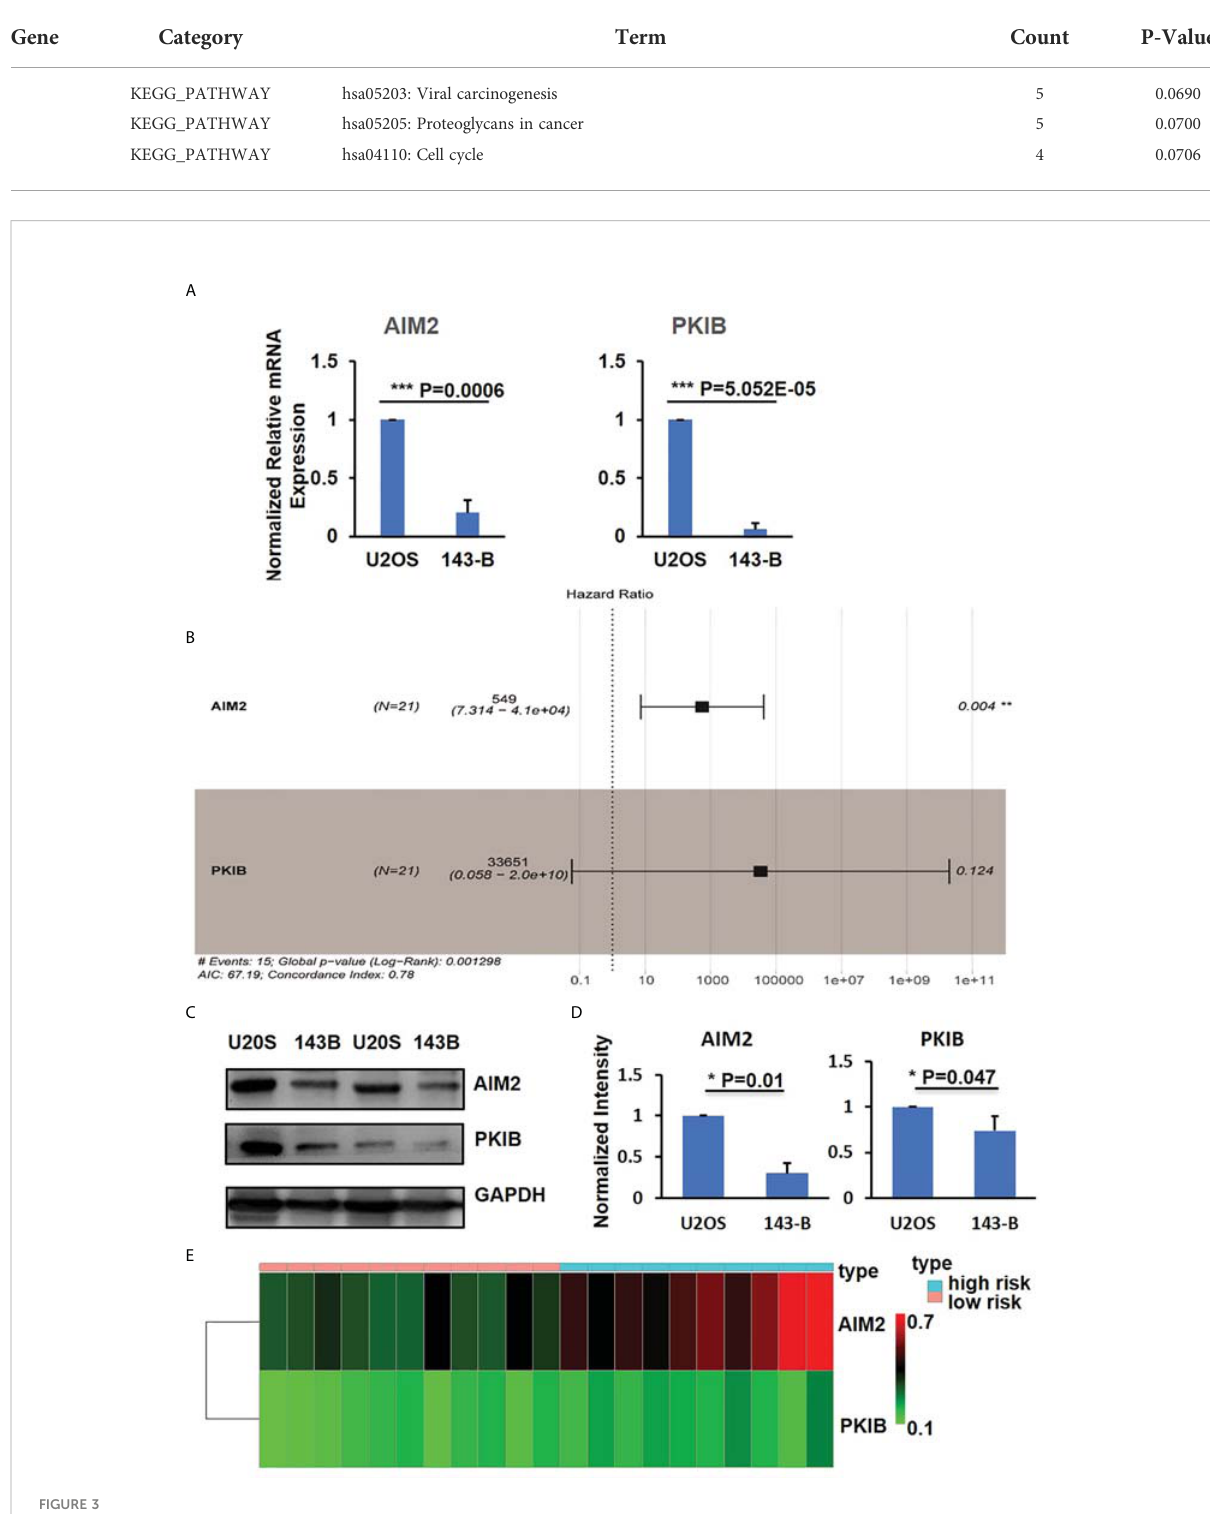
FIGURE 3 PKIB and AIM2 involved in survival of osteosarcoma. (A) Q-PCR results to show the expression level of AIM2 and PKIB genes. (B) Multivariate Cox regression analyses of AIM2 and PKIB genes with overall survival. (C) Representative images of western blot to show the protein expression level of AIM2 and PKIB. (D) Bar graphs showed the normalized protein expression intensity of AIM2 and PKIB. (E) The distribution of AIM2 and PKIB DNA methylation level. n>3, Error bars: Mean±SD.